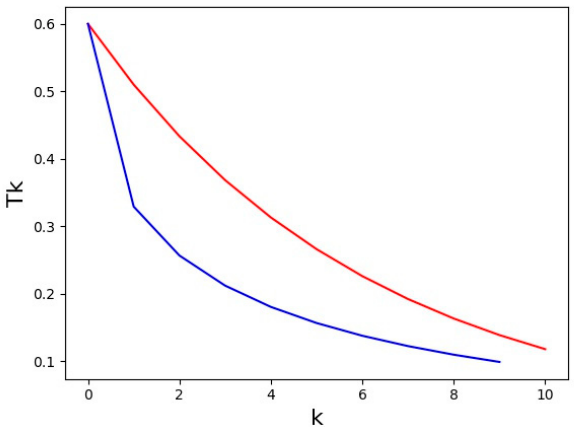
Figure 3. Cooling schedules for “log” (red, Equation (5), s = 0.8) and “fast” (blue, Equation (6), c = 0.6, q = 0.5) starting at T 0 = 0.6.